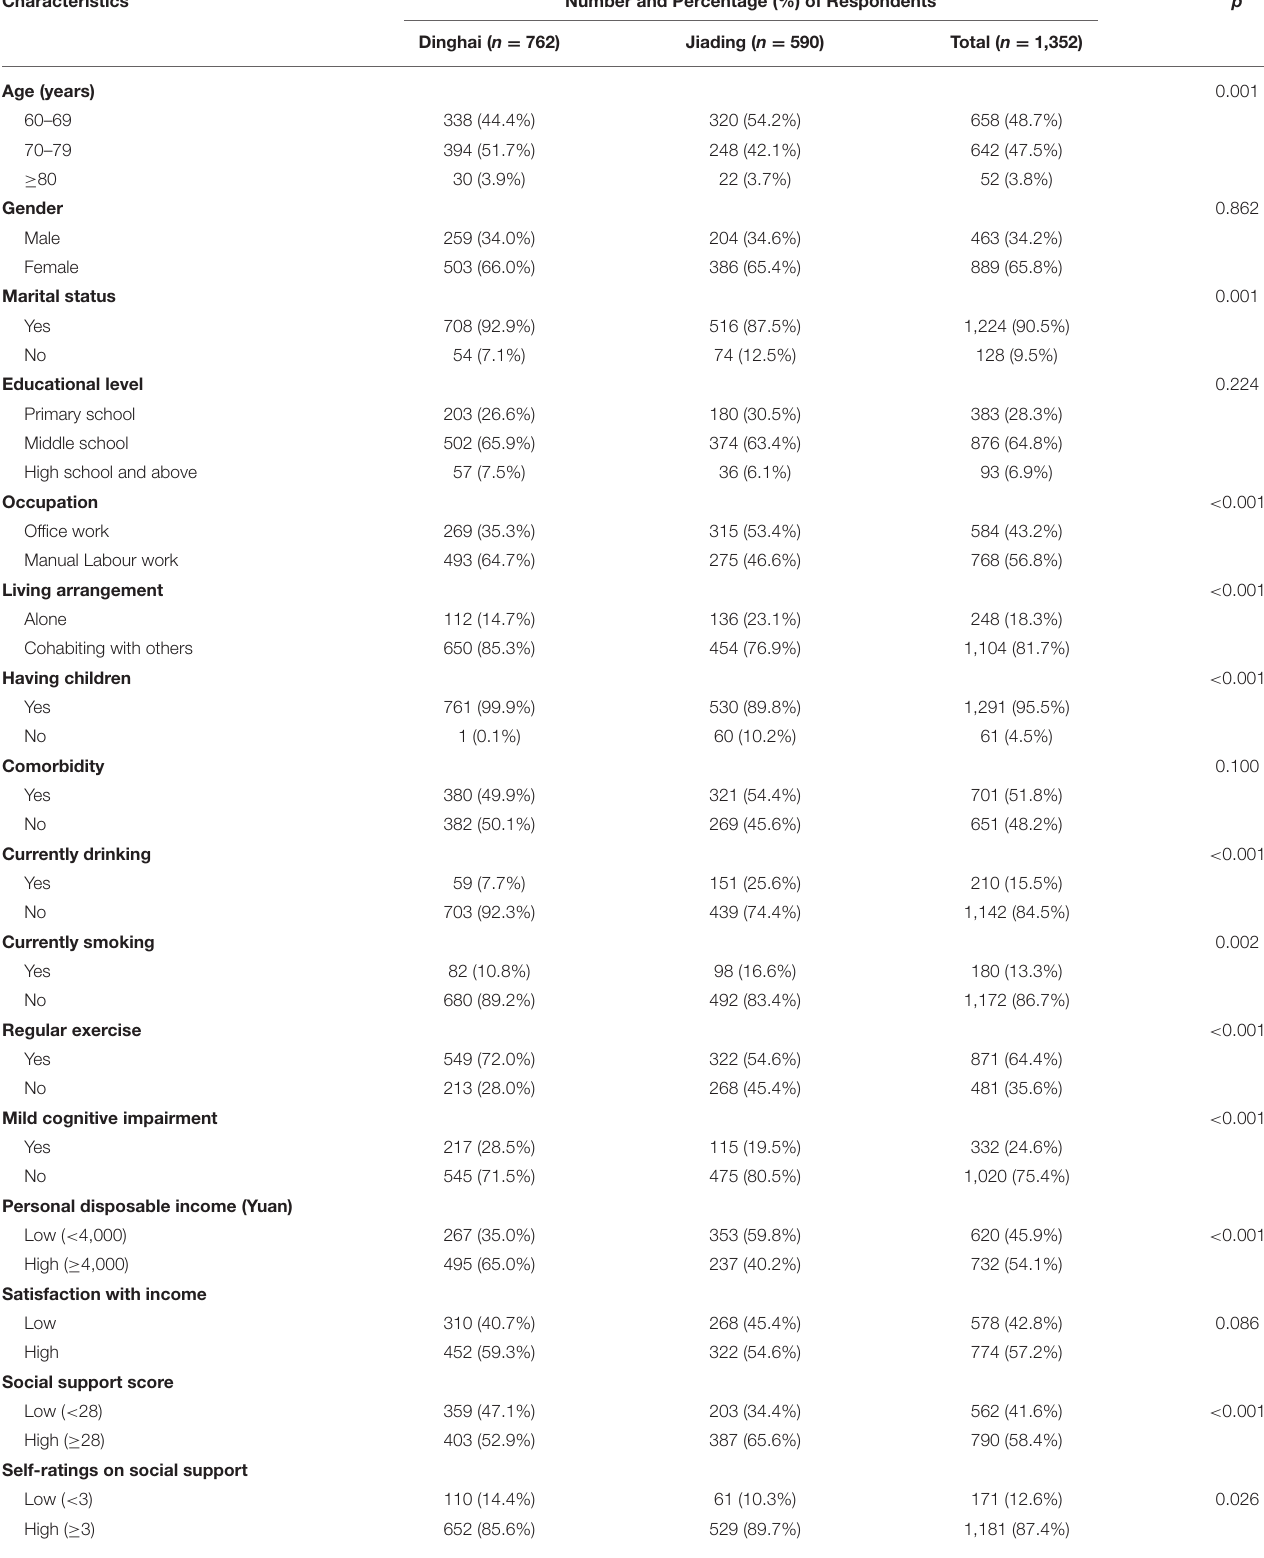
TABLE 1 | Demographic characteristics of the participants ( n = 1,352).